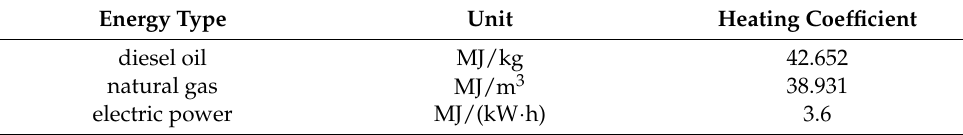
Table 6. Energy calorific value of energy